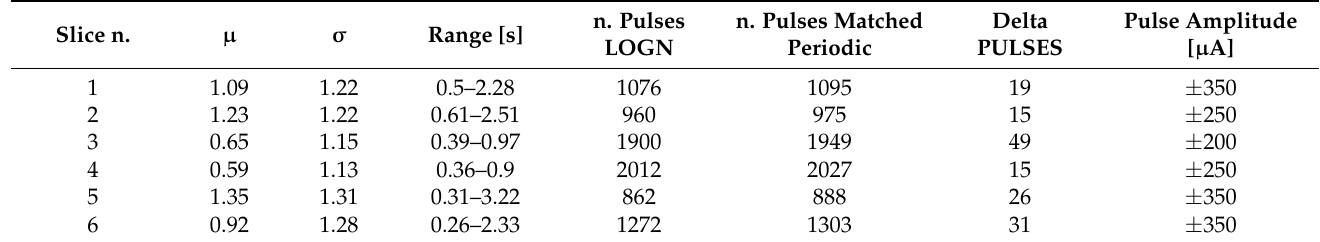
Table 4. Stimulation parameters for the dataset summarized in Figure 5. Slice